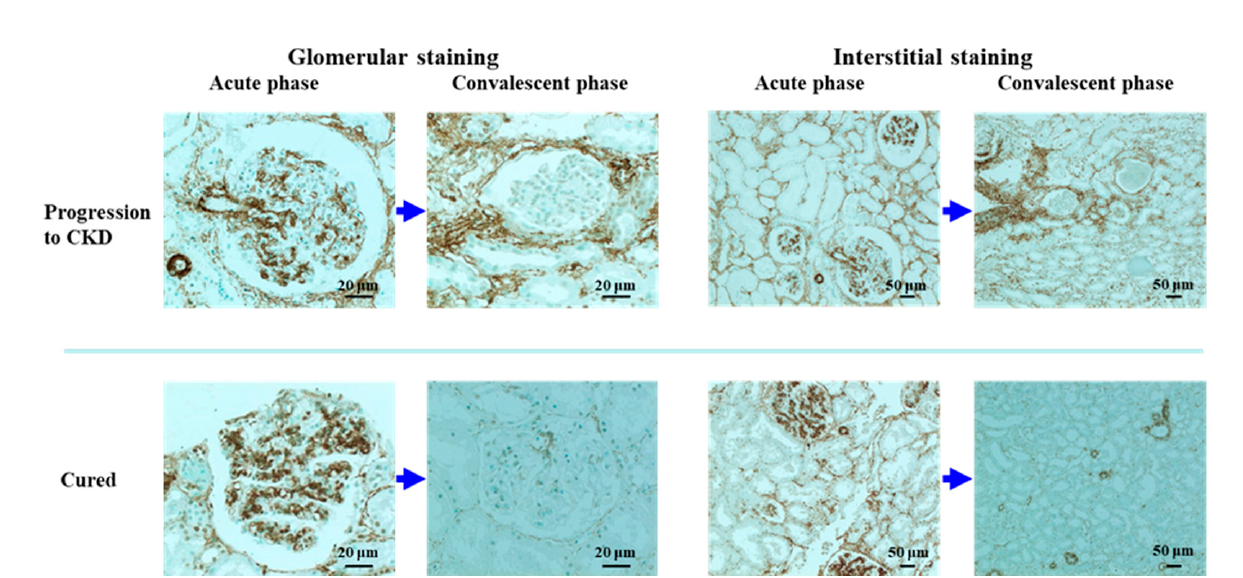
Table 2. Alpha-smooth muscle actin staining scores of renal biopsy tissues sampled repeatedly from 6 PSAGN patients and their characteristics.